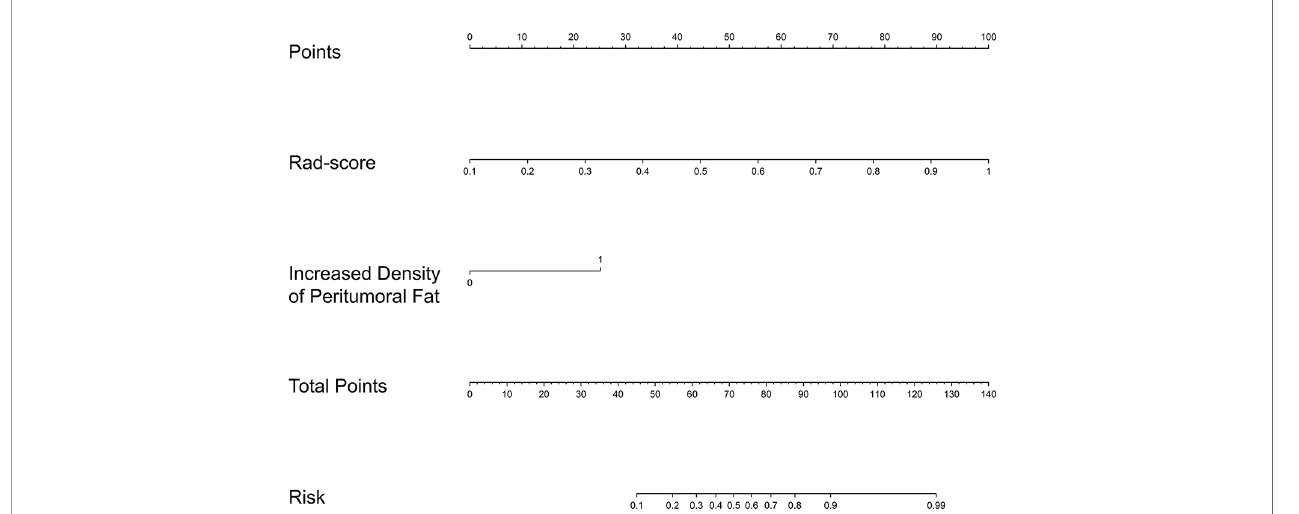
FIGURE 6 | A individualized nomogram based on Rad-score and traditional feature.